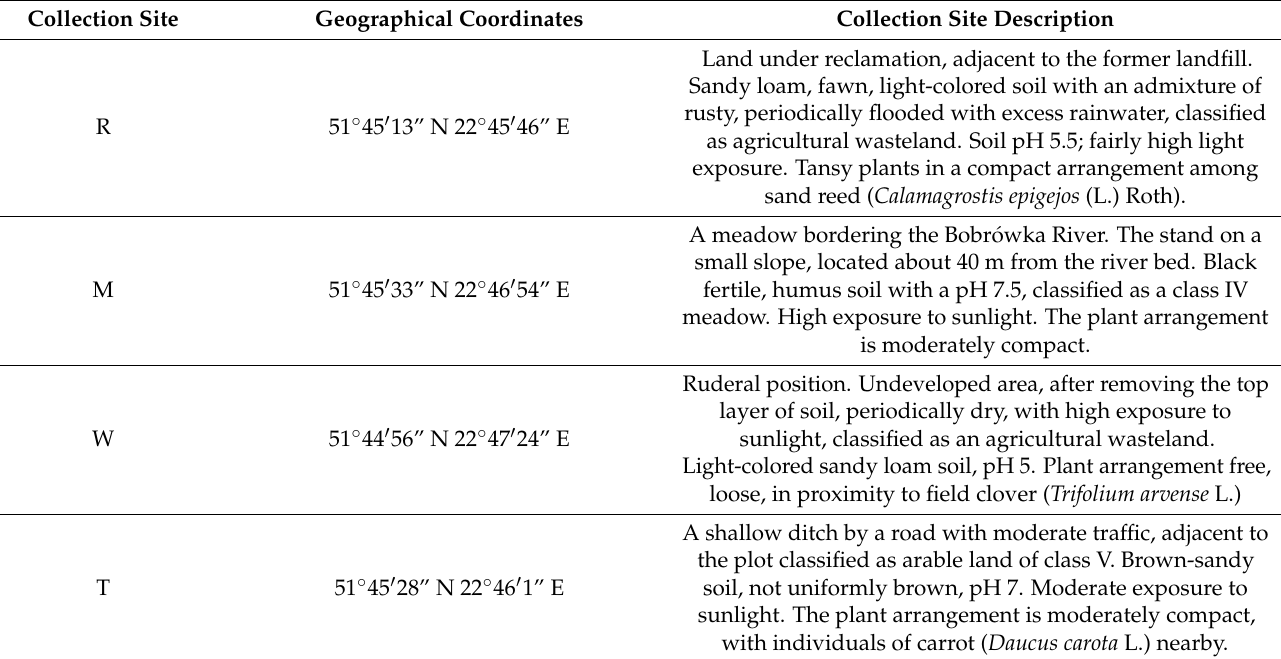
Table 1. Description of natural tansy sites covered in the